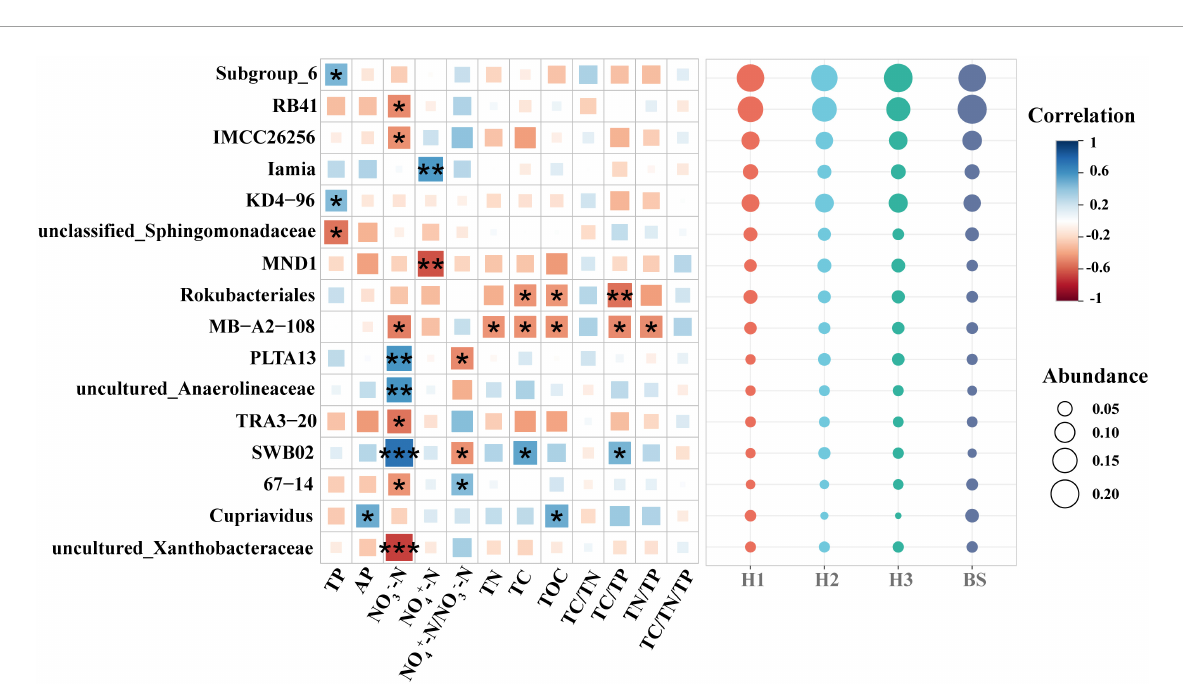
(Delgado-Baquerizo et al., 2017). According to the